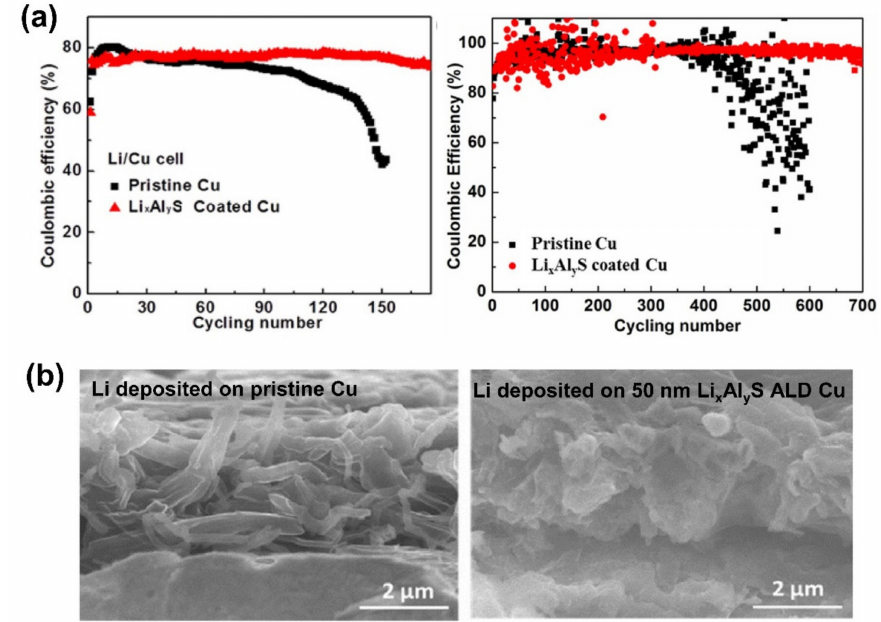
Figure 4. ( a ) CE of Li deposition/striping in 1 M LiPF 6 in 3:7 EC/EMC and 4 M LiTFSI in DME with pristine Cu and Li x Al y S-coated Cu. ( b ) Cross-sectional SEM images of Li metal deposited on pristine Cu and 50 nm Li x Al y S-coated Cu [86]. Reproduced with permission [86]. Copyright 2016,